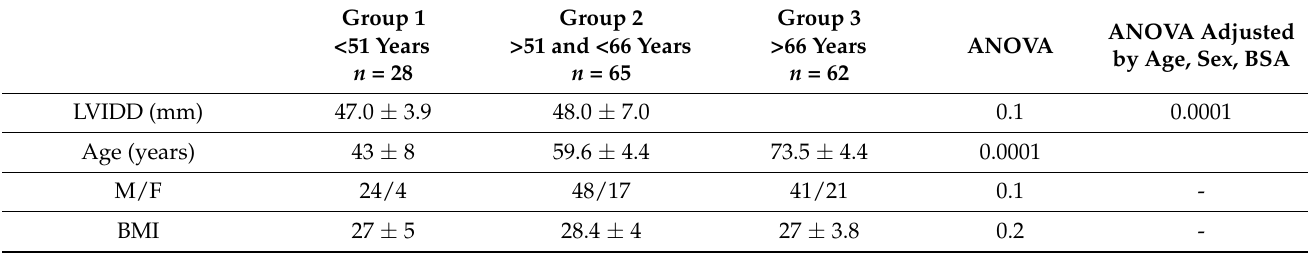
Table 4. Hypertensive patient characteristics divided by